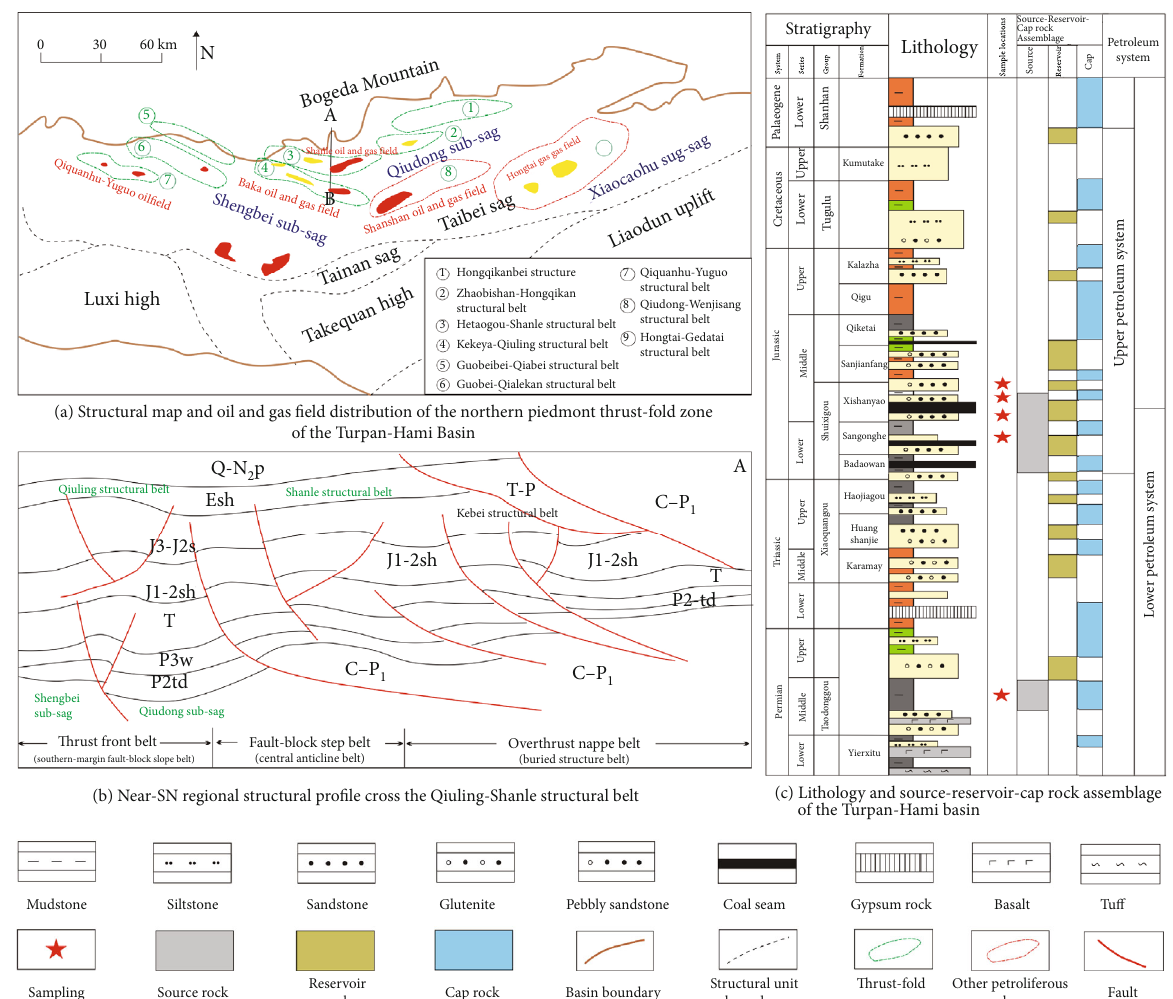
Figure 1: Geological background of Turpan-Hami Basin (modi fi ed according to literature [14]). (a) Structural map and oil and gas fi eld distribution of the northern piedmont thrust-fold zone of the Turpan-Hami Basin. (b) Near-SN regional structural pro fi le cross the Qiuling-Shanle structural belt. (c) Lithology and source – reservoir-caprock assemblage of the Turpan-Hami